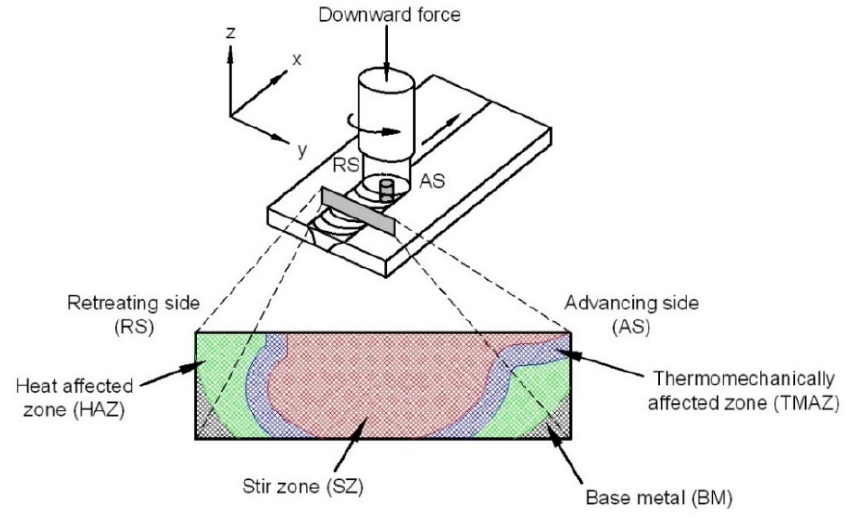
Figure 2. Different welding zones.